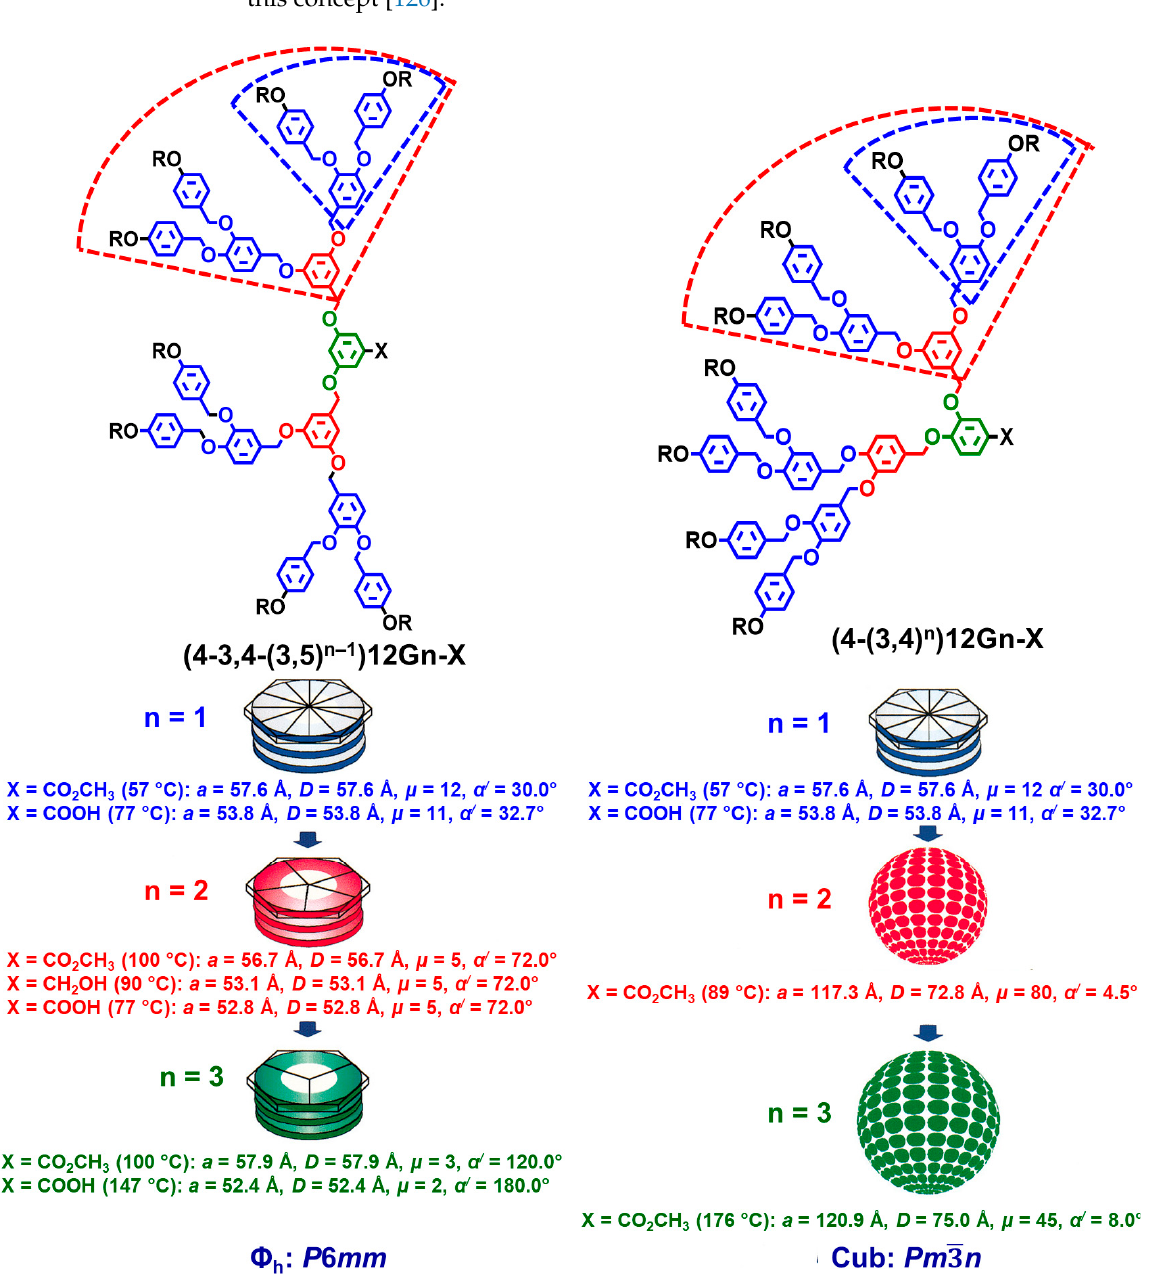
Figure 10. An example demonstrating the constitutional isomerism of the branching point a ff ecting the supramolecular organizations. Structural and retrostructural analysis of supramolecular dendrimers self-assembled from AB 2 3,5-disubstituted dendron is shown on the left side and of its constitutional isomeric AB 2 3,4-disubstituted dendron is shown on the left side [126]. Parts of the Figure were adapted, combined, and modified from [126]. Copyright © 2004, American Chemical Society.